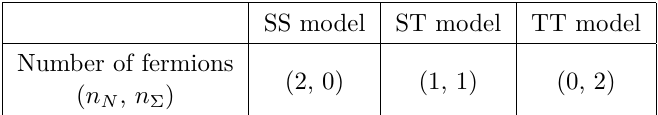
Table 2 . Number of fermions in each